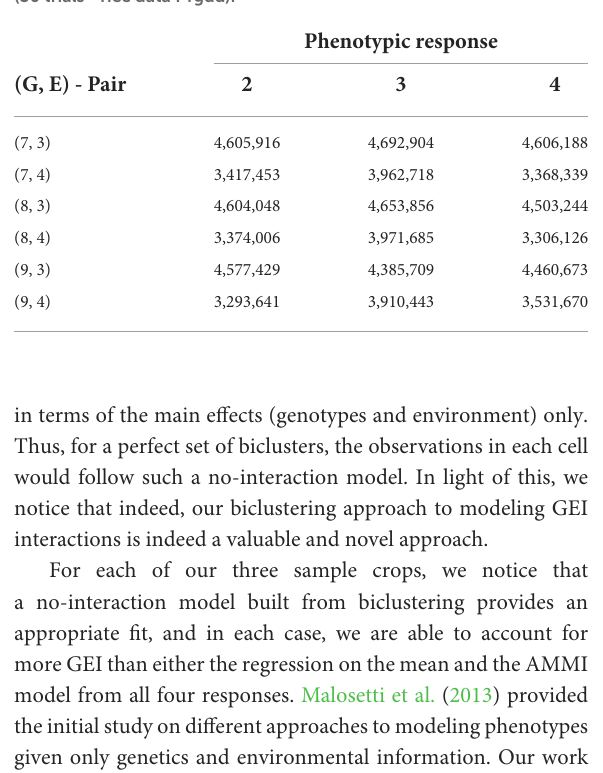
TABLE 6 Summary of degrees of freedom and sum of squares for the rice dataset—FTgdd.